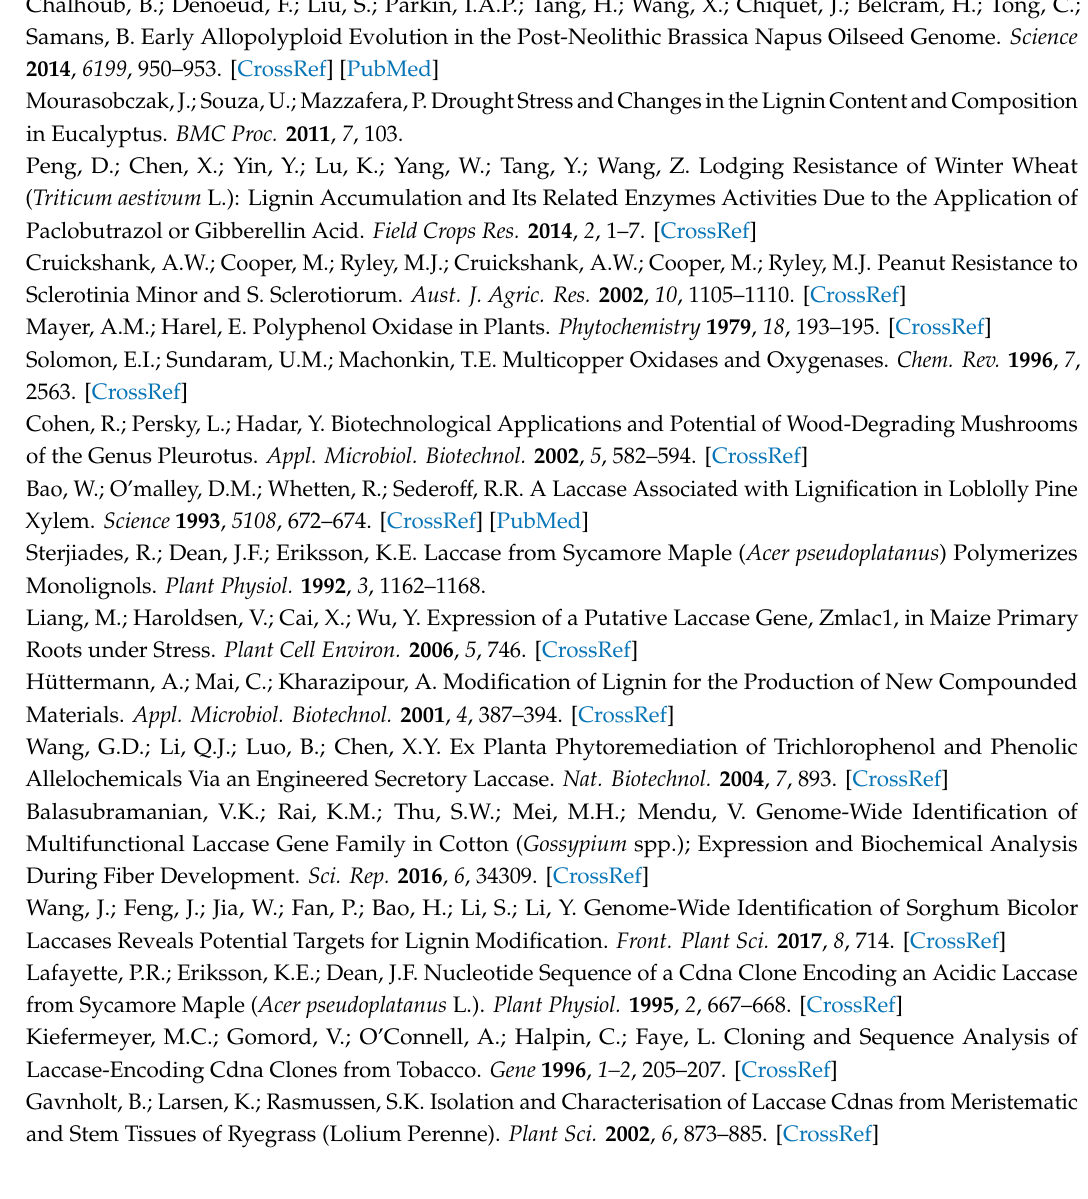
Table S1: Motif sequences of conserved motif analysis, Table S2: Putative cis-elements in 45 BnLACs promoters, Table S3: List of BnLACs with putative miRNA target sites, Table S4: Expression levels of the BnLACs in di ff erent tissues and stages of B. napus . The values represent the FPKM values, Table S5: Expression levels of the BnLACs under Cd 2 + , NH 4 + enrichment treatment. The values represent the FPKM values, Table S6: Expression levels of 14 selected BnLACs in the L(leaf) and S(stem) of the three lines under drought and wound stress, Table S7: Expression levels of BnLAC4, BnCTL2, BnIRX3, BnCESA4, BnIRX1, BnLAC17, BnGAUT12, BnIRX6, BnPGSIP1, BnGLP10 and BnFLA11 genes in 6 kinds of silique pericarps. The values represent the FPKM values, Table S8: Primers used for qRT-PCR